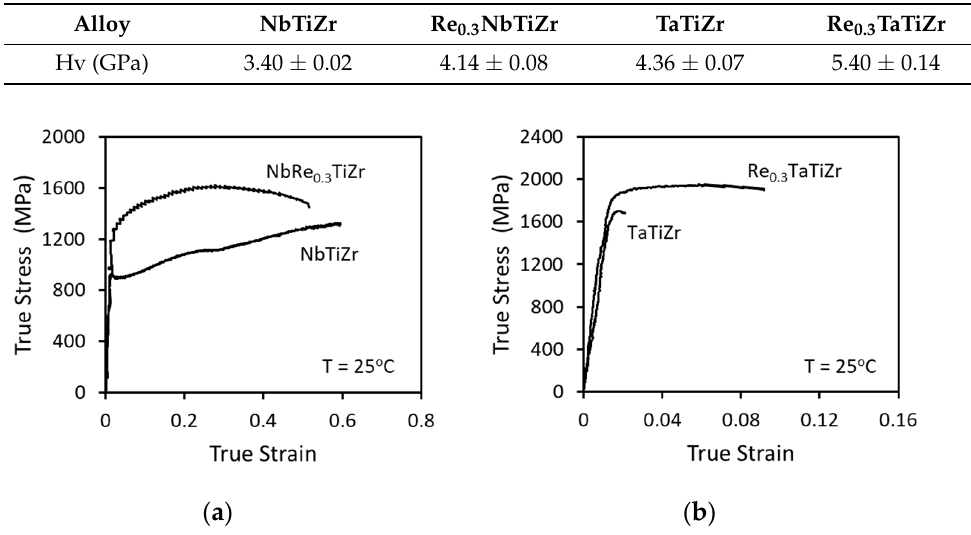
Table 2. Vickers hardness of the studied alloys at room temperature.